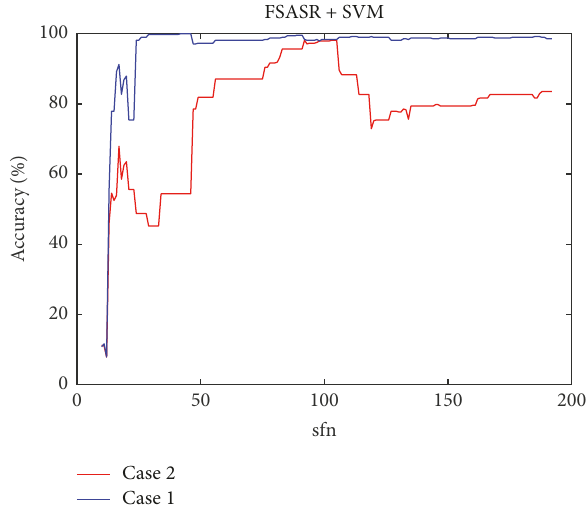
Figure 10: The diagnosis results of OFS-FSASR-SVM using MOD- WPT with different sfn.